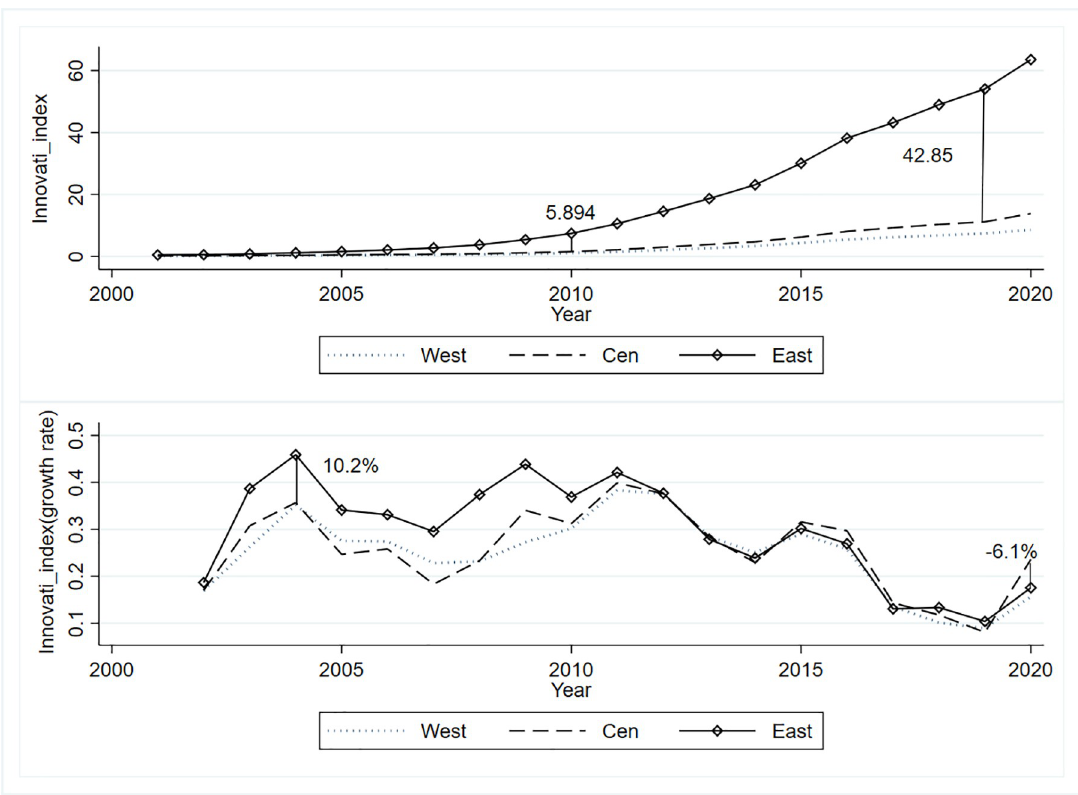
Fig 1. Dynamic evolution of urban innovation